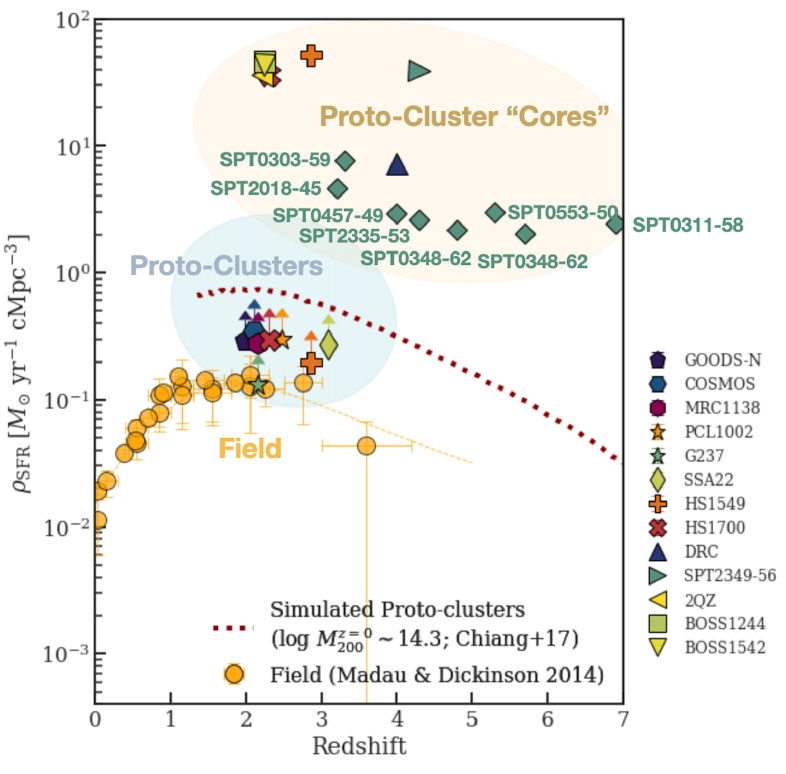
Figure 11. The SFRD of proto-clusters and proto-cluster cores with DSFG overdensities at z ∼ 2–7 (Table 3) in comparison with the field [142]. Most of these proto-clusters will have a z = 0 halo mass comparable to the Coma Supercluster (log M z = 0 / M (cid:12) (cid:38) 15). Caution: the volumes assumed 200 are highly uncertain and inhomogeneously derived; a robust analysis requires more uniform volume definitions be adopted in the literature. The total SFRs are also often underestimated due to membership/spectroscopic incompleteness. For comparison, we show the projected SFRD for proto-clusters with a z = 0 halo mass of log M 200 / M (cid:12) ∼ 14.3 from [21] (red dotted line). Coma progenitors sit above the field but as lower limits, a comparison to theory is limited. Proto-cluster cores, however, are up to a few orders of magnitude in excess of the field when considering the central DSFG overdensity. See Table 3 for the relevant